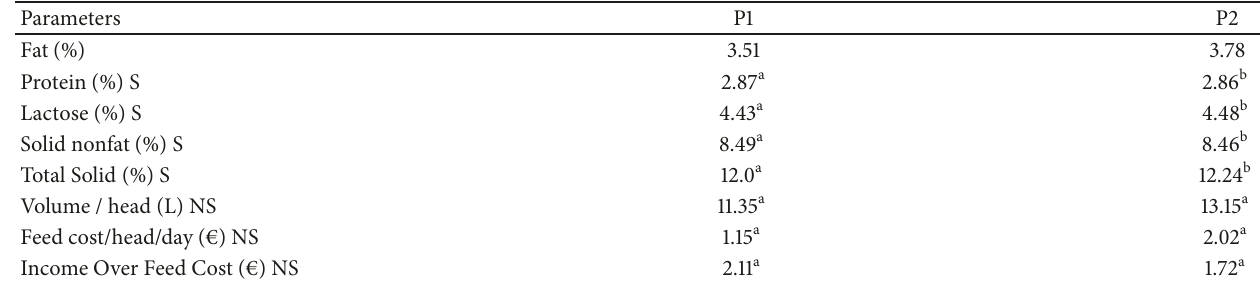
Table 2: Milk quality and quantity of the treatments